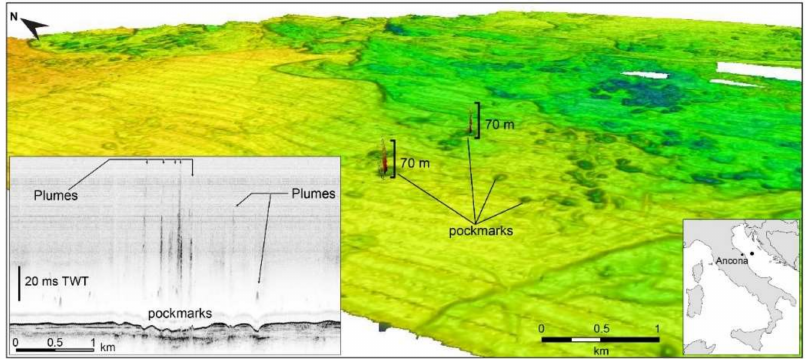
Figure 7. 3D view of seafloor and water column reflectivity multibeam data in the Bonaccia area, some 30 nautical miles o ff shore Ancona ( lower right ). Up to 70-m-high gas plumes correspond to pockmarks on the seafloor and are visible also in the water column recorded by the CHIRP seismic profile ( lower left